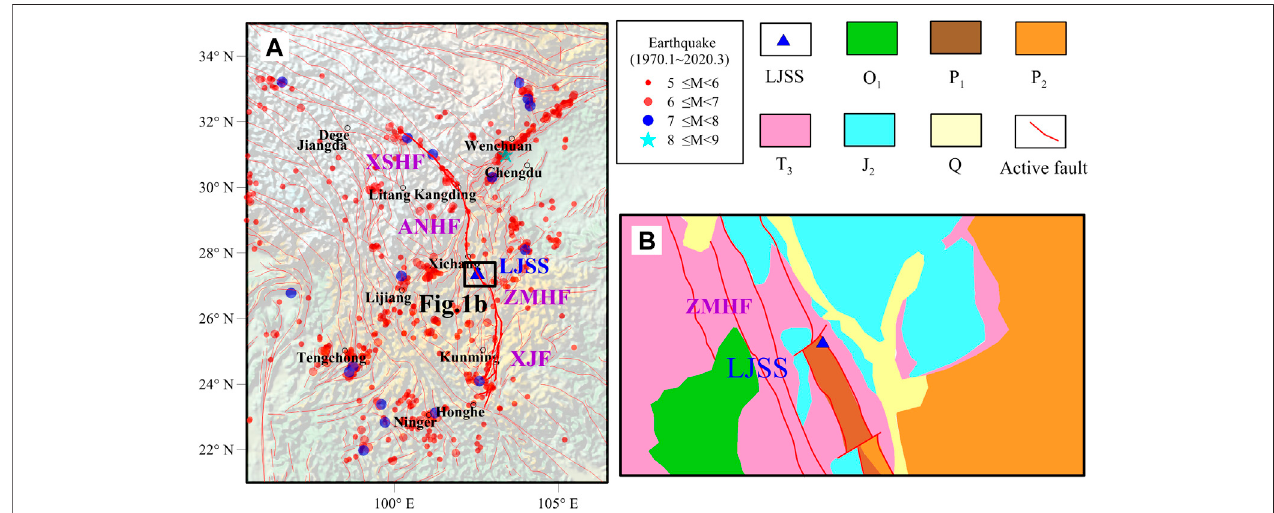
FIGURE 1 | Location of the Luojishan station (LJSS) (A) Topographic map of the east Tibetan Plateau. (B) Geological map of the Luojishan station and around are shown in (A) . Abbreviations: LMSF, Longmenshan Fault; ANHF, Anninghe Fault; XSHF, Xianshuihe Fault; ZMHF, Zemuhe Fault; XJF, Xiaojiang Fault.